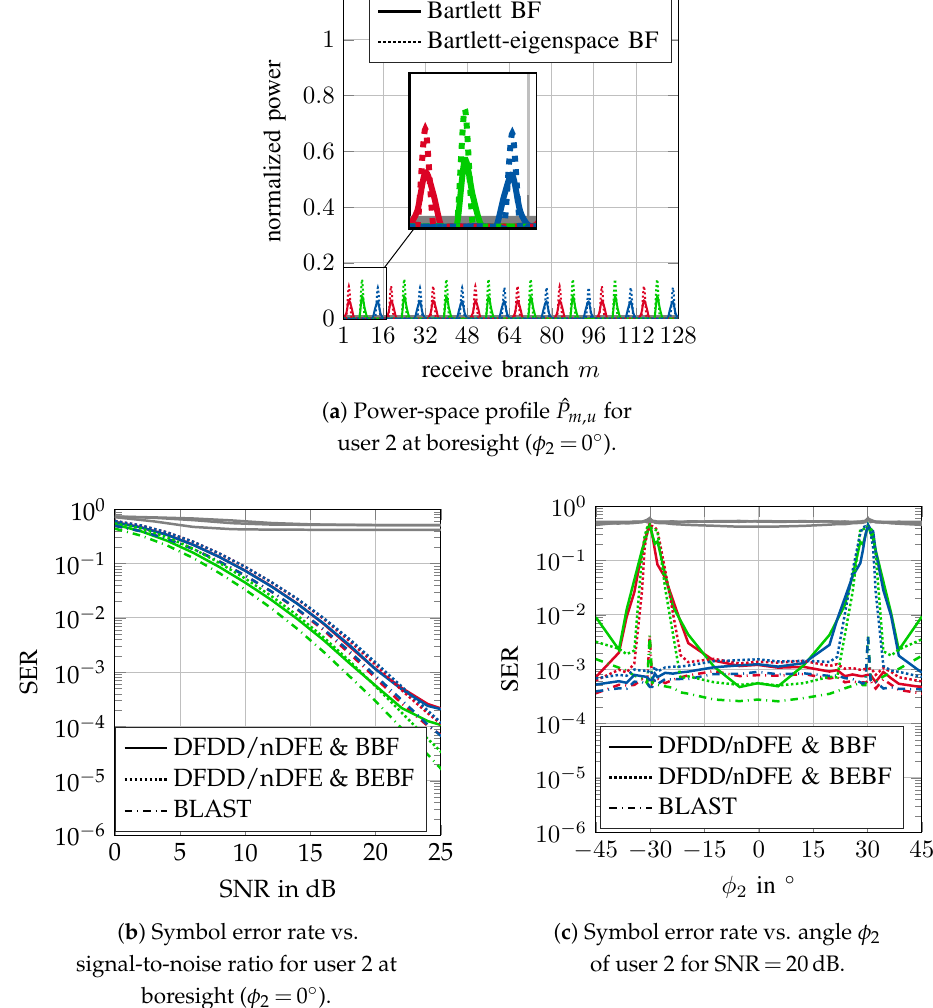
Figure 5. Sub-array architecture of N sub = 8 and N rx , sub = 16: Power-space profile and symbol error rate performance. Colors correspond to users: user 1 ( ), user 2 ( ), user 3 ( ). Gray plots ( ) represent results without digital beamspace preprocessing for each